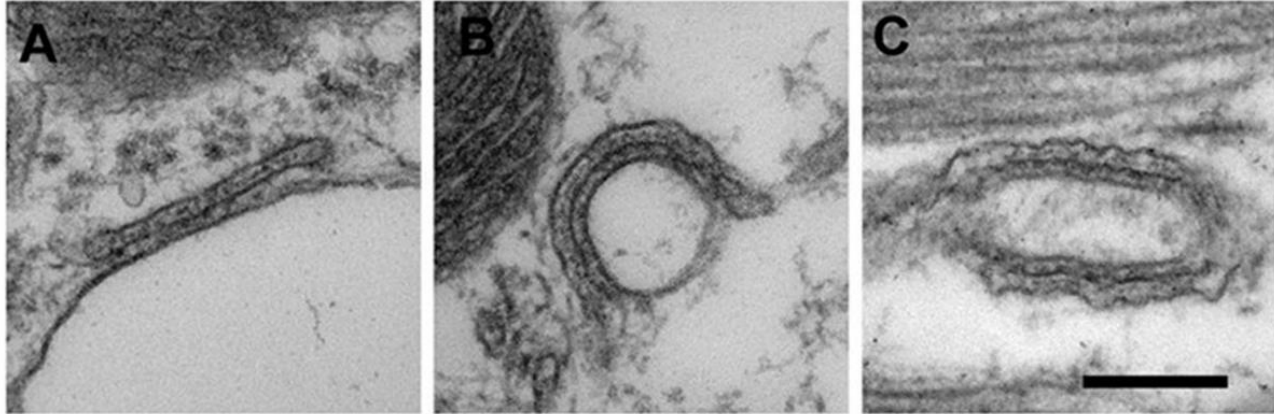
Figure 5. EM images and relative quantitative analysis of CRUs. ( A – C ) Representative EM images of a peripheral coupling (PC, panel A ) and of CRUs formed by either one or two couplons (panels B , C , respectively). Scale bar: 0.2 µm.